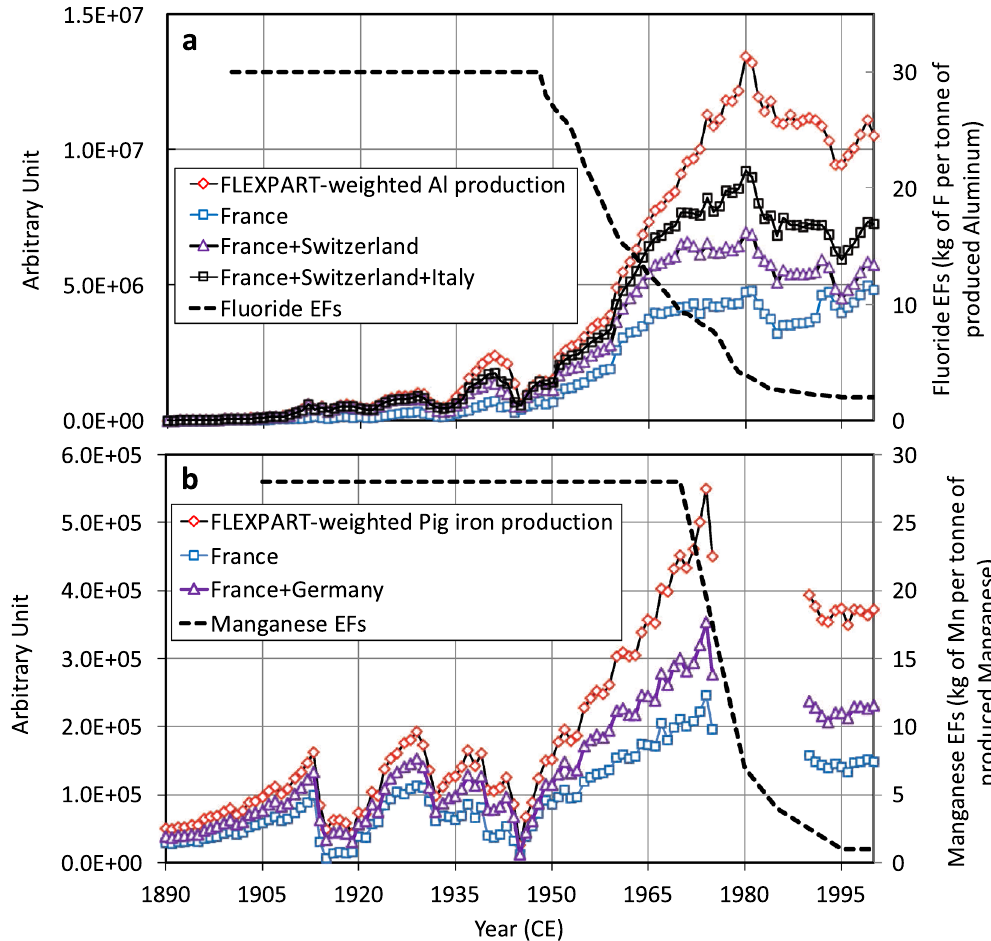
Figure 2. Production of Al ( a ) and pig iron ( b ) from European countries (https:// www2. bgs. ac. uk/ miner alsuk/ stati stics/ world Archi ve. html) scaled by emissions sensitivities estimated by FLEXPART. The dashed black lines are past EFs for F and Mn emitted by Al and pig iron productions, respectively (Table